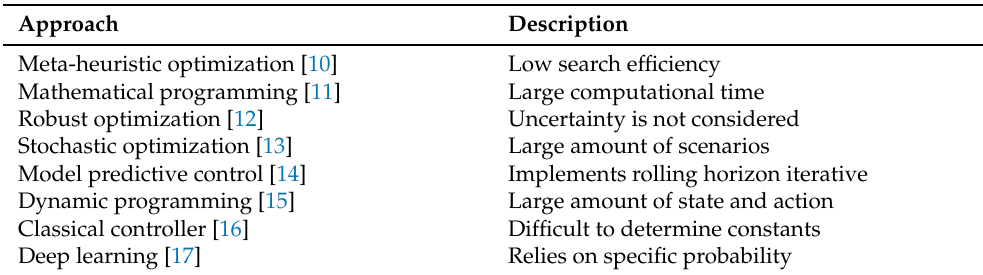
Figure 4. Comparison between a system with centralized and distributed generation. Table 1. Strategy applied in optimal